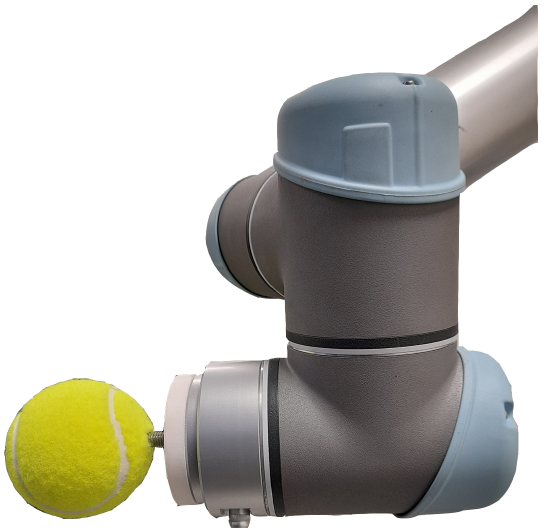
Figure 1. The designed prop, a physical representation of the virtual objects presented to the user during